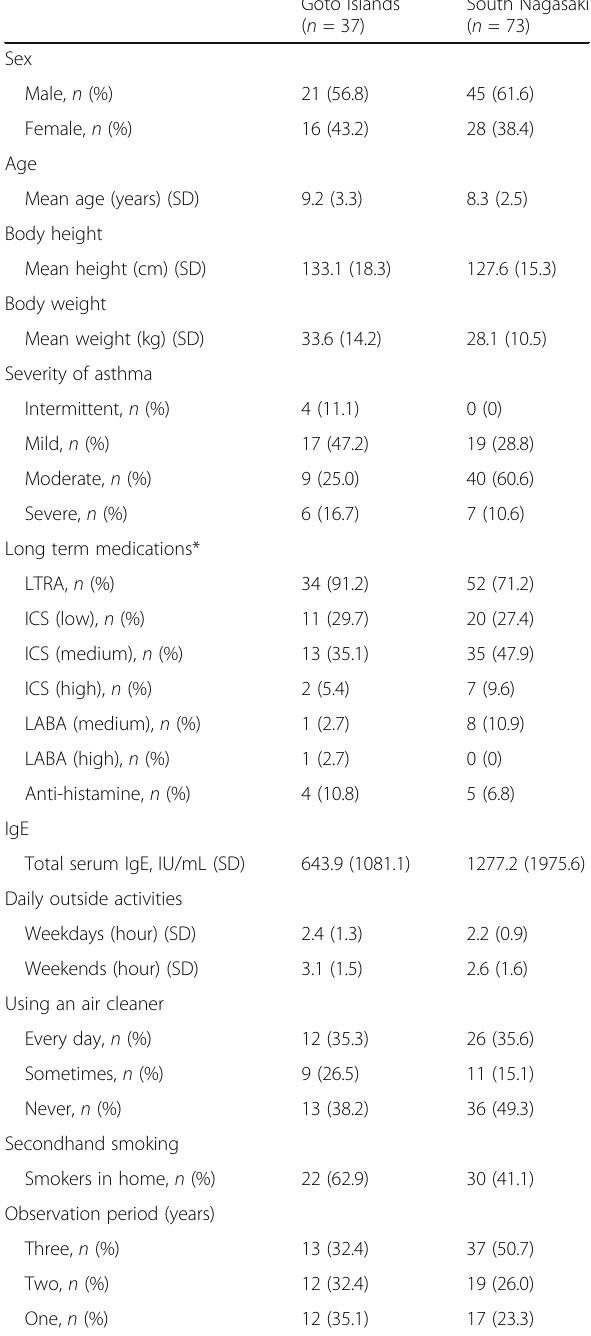
Table 1 Baseline characteristics of participants between 2014 and